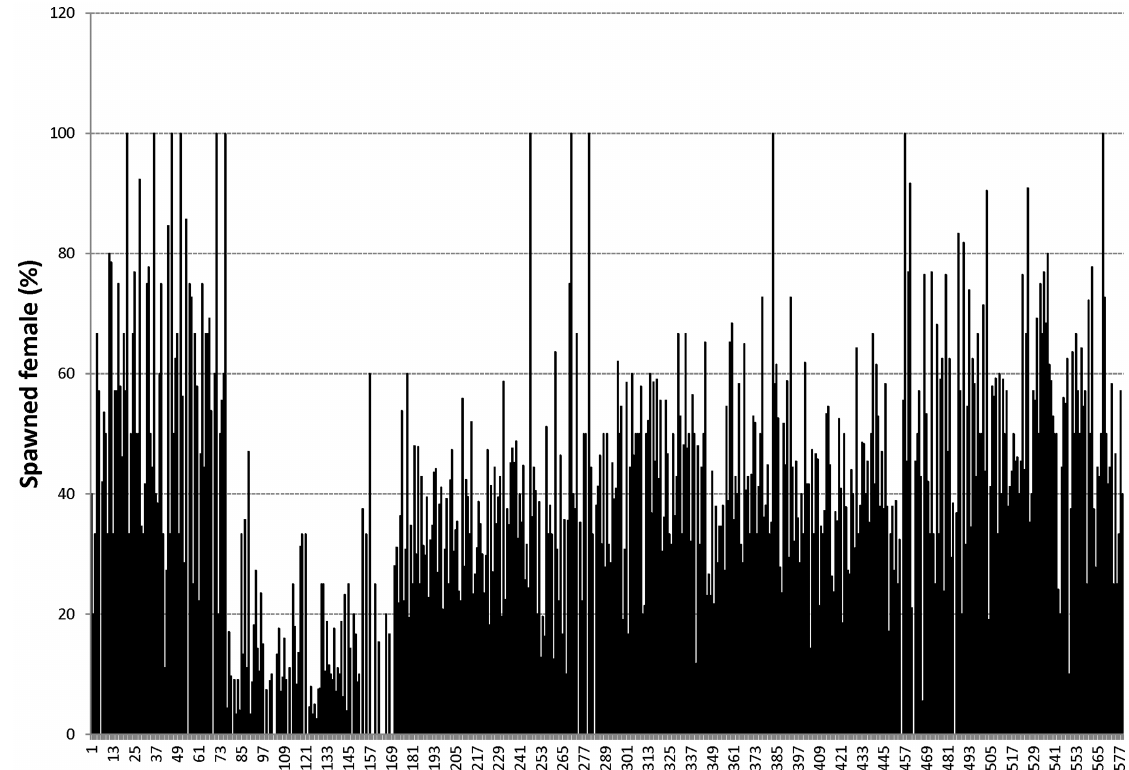
Figure 8. Spawned female.